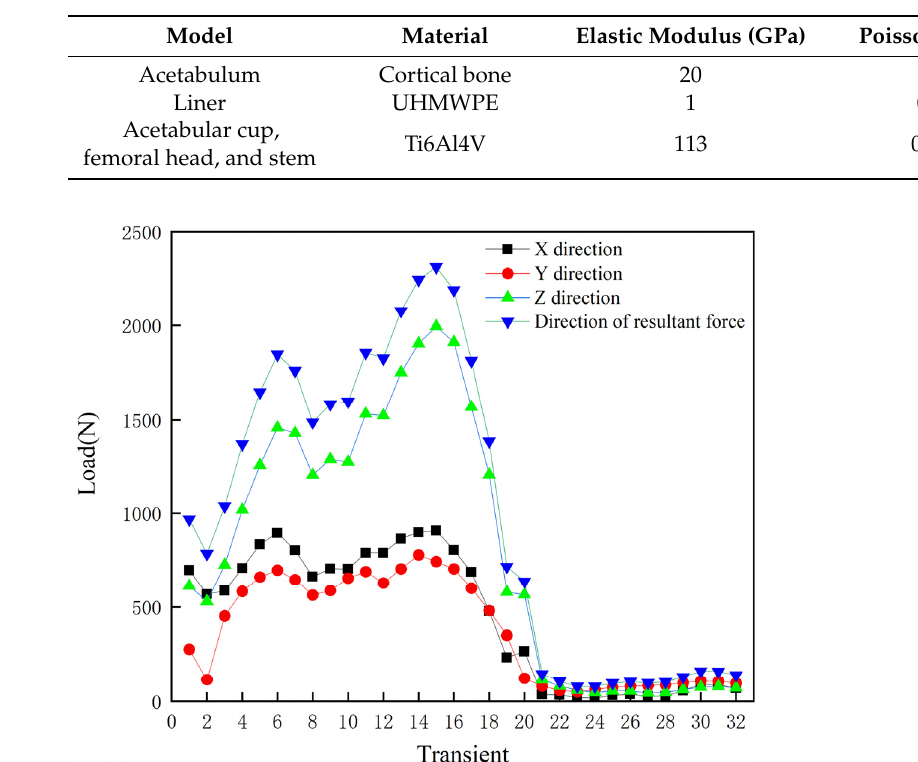
Figure 4. Finite element model of the total hip joint. Table 3. Material properties of the total hip joint model.